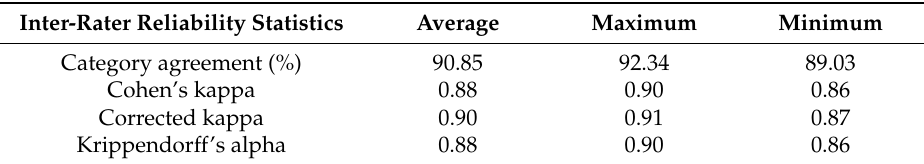
Table 6. Inter-rater reliability statistics for the in-lab scenario.